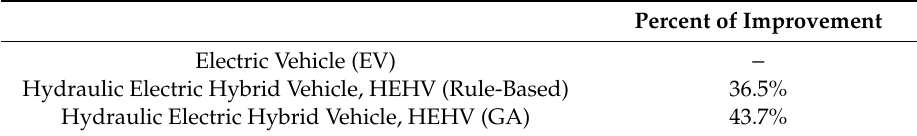
Table 5. Electricity improvement